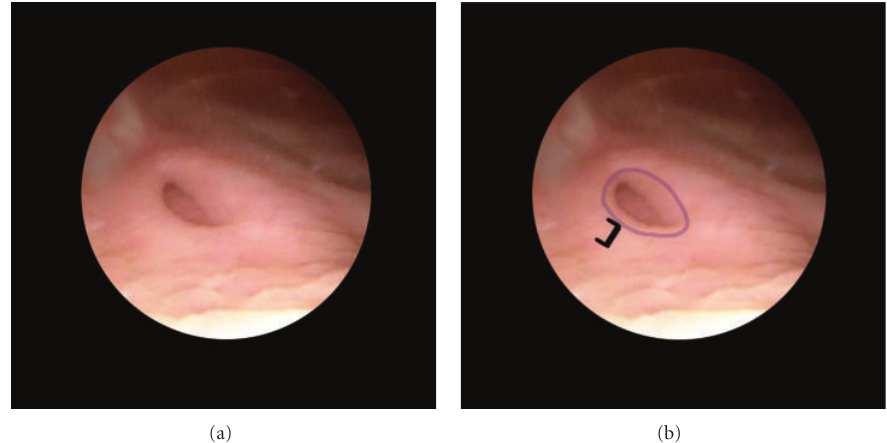
Figure 1: Procedure as CEVL components in a case of grade IV reflux in an infant girl. Inspect the ureteral orifice. The ureteral orifice is identified. It is patulous (blue ring) laterally positioned (not evident in this close-up view) and is almost flush with the bladder surface (as indicated by the graduated rule). It shows HD3 (not shown). In selected images which follow, this image is used as a reference for the original appearance of the orifice before reconstruction.